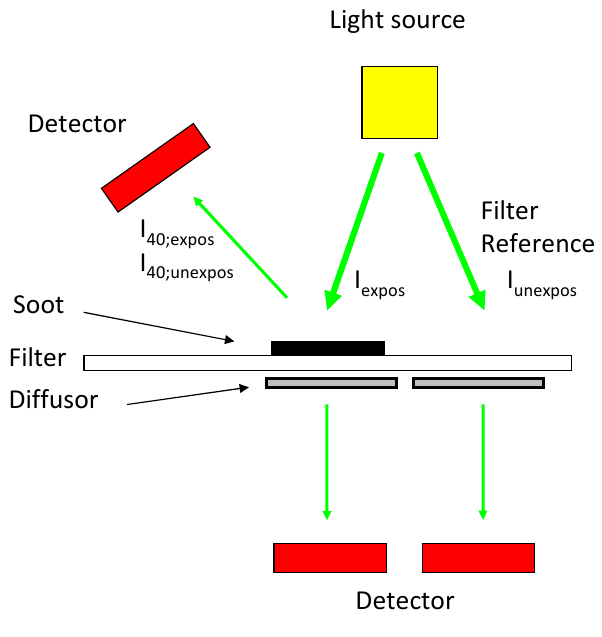
Fig. 2. The principle of the photometer